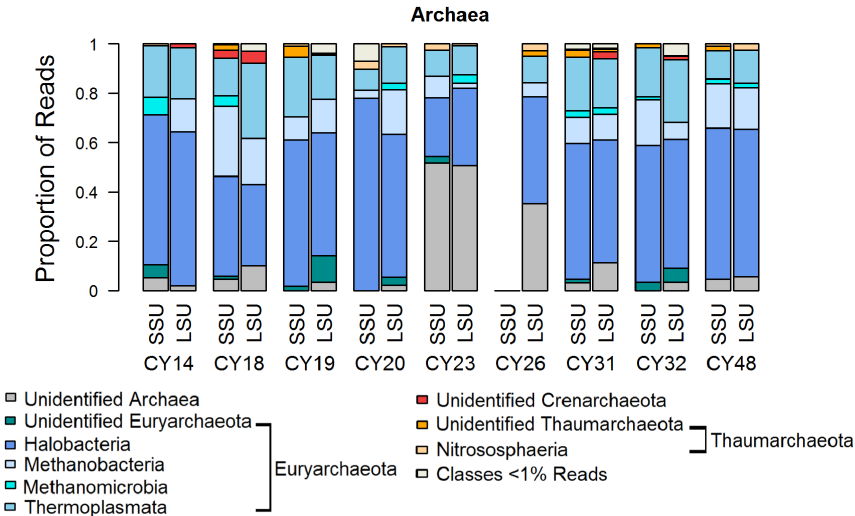
Figure 6. Taxonomic composition of Archaea. Taxonomic classification and proportion of SSU and LSU reads of Archaea at the class level.